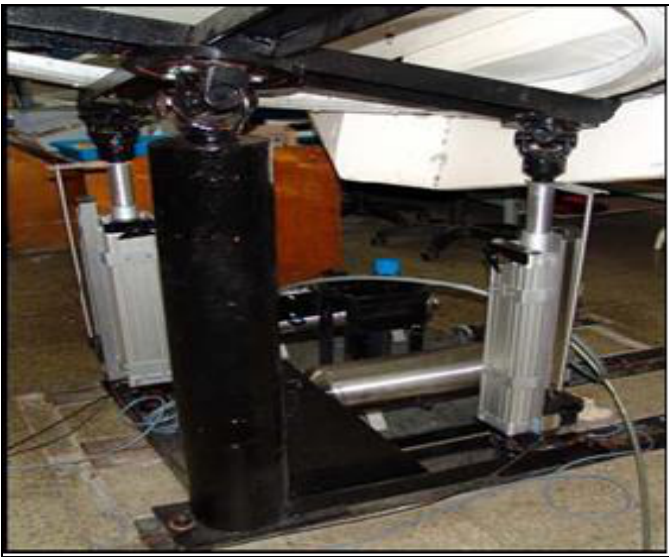
Figura 1: Simulador industrial de conducción SIMPRO de 2 GDL. Fuente: Autores, (2010).